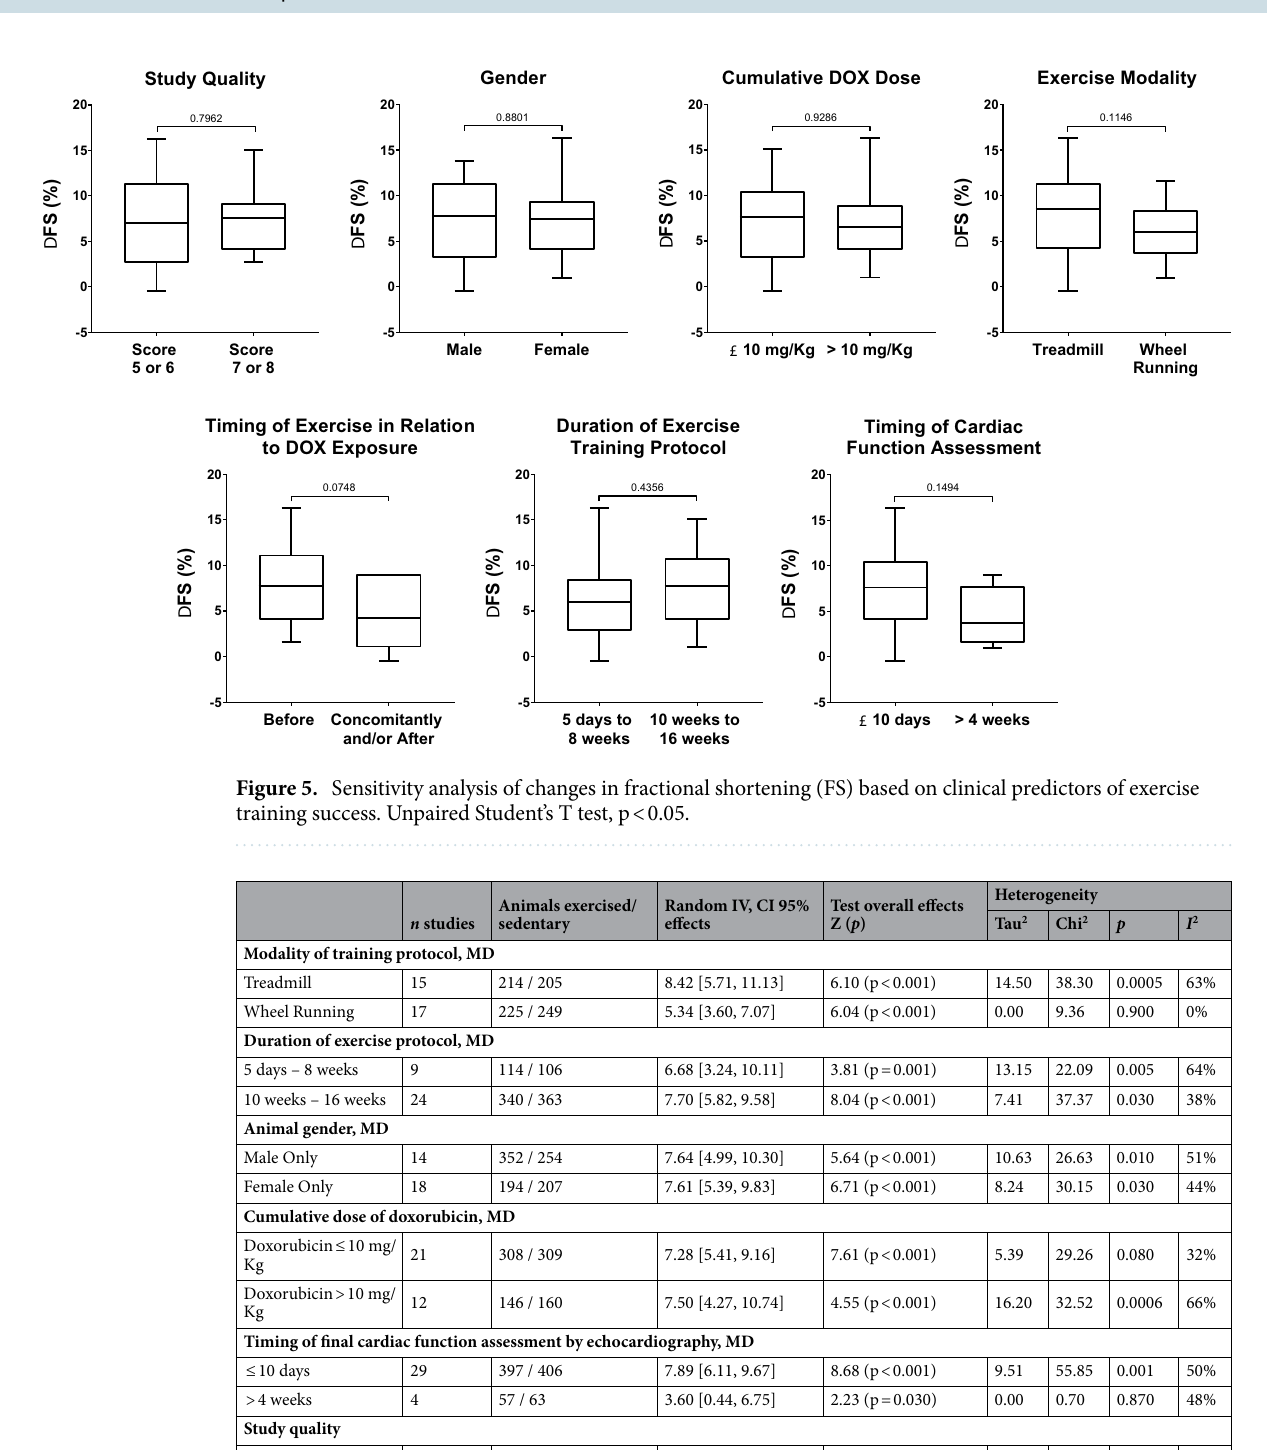
Table 2. Summary of the subgroup analyses on fractional shortening from the included studies. MD mean difference, IV inverse variance method, CI confidence interval.